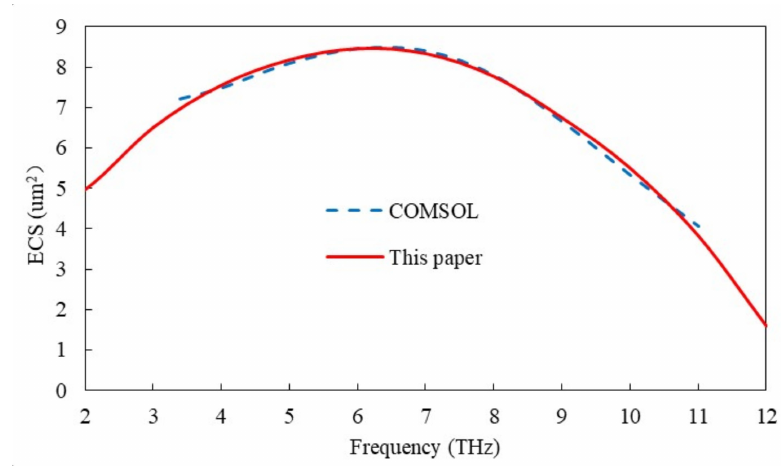
Figure 7. ECS of the trilayer graphene with